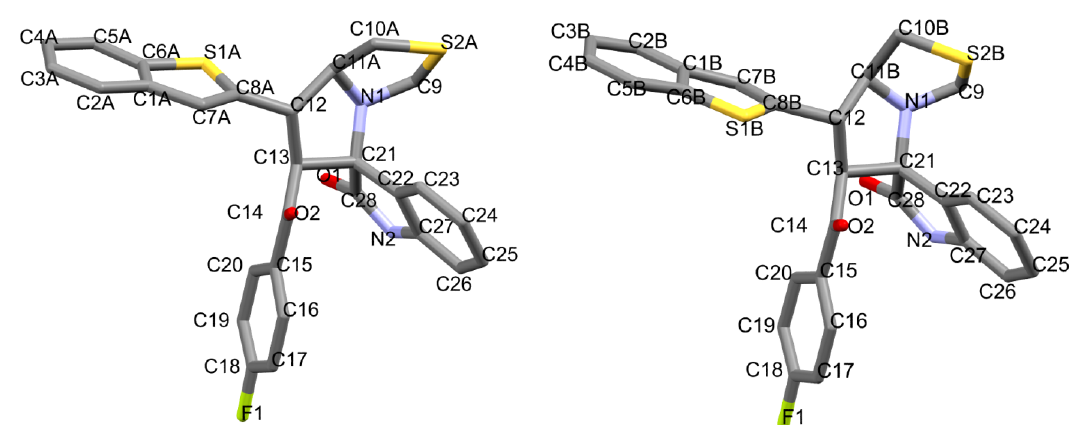
Figure 2. ORTEP structure of 5 showing the disordered system over two positions with equal partial occupancies at 50% probability level (upper) and the atom numbering of each part (lower) showing the two conformers of the studied system where hydrogen atoms and the methanol molecule were omitted for better clarity.